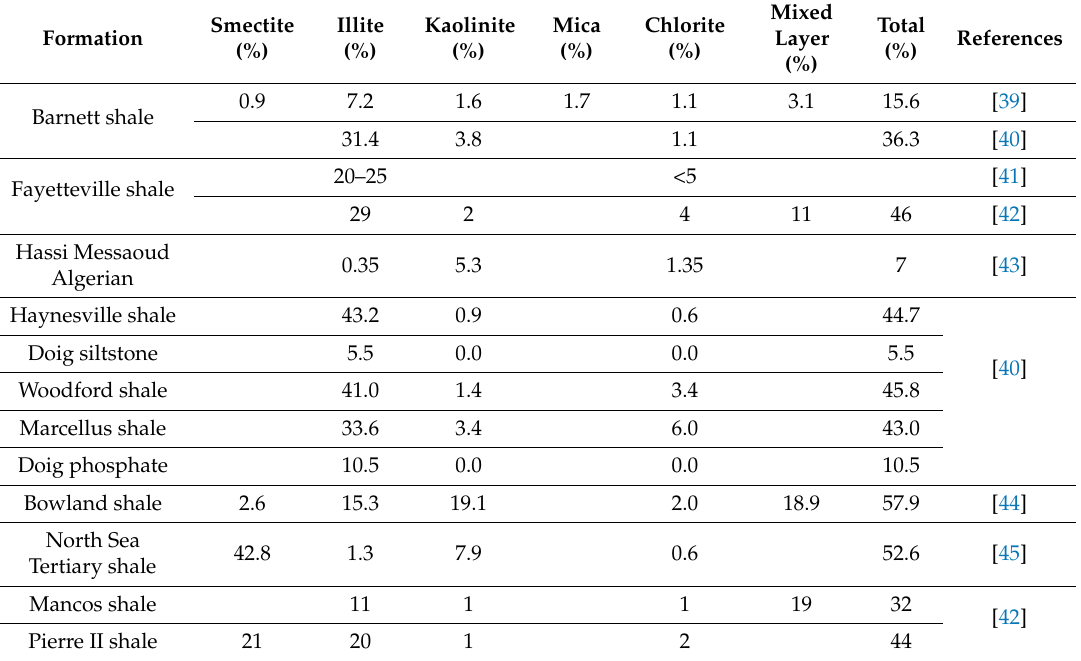
Table 1. Clay content in shale